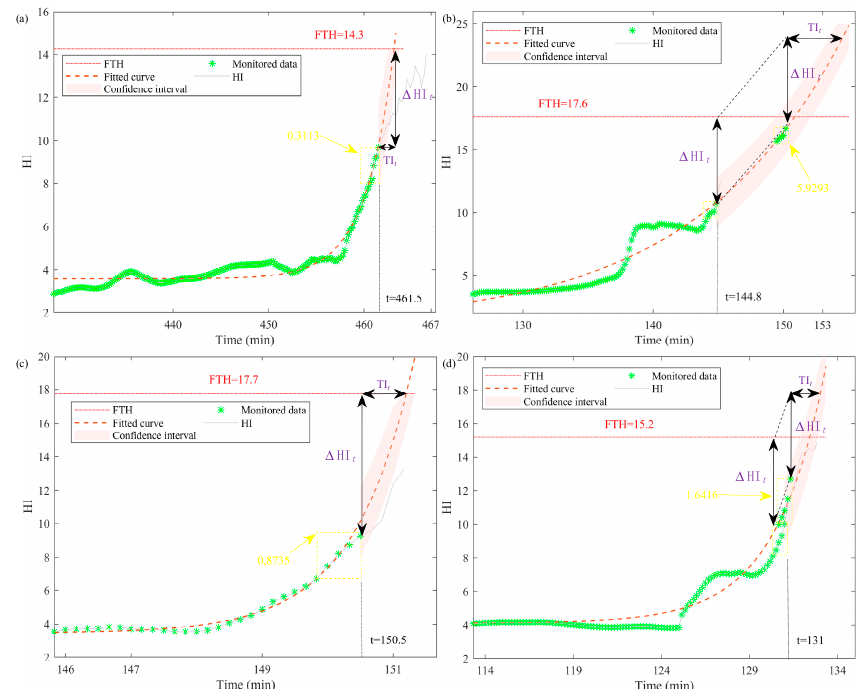
Figure 12. Degradation prediction of ( a ) bearing 1_1, ( b ) bearing 1_2, ( c ) bearing 2_1, and ( d ) bearing 2_2.